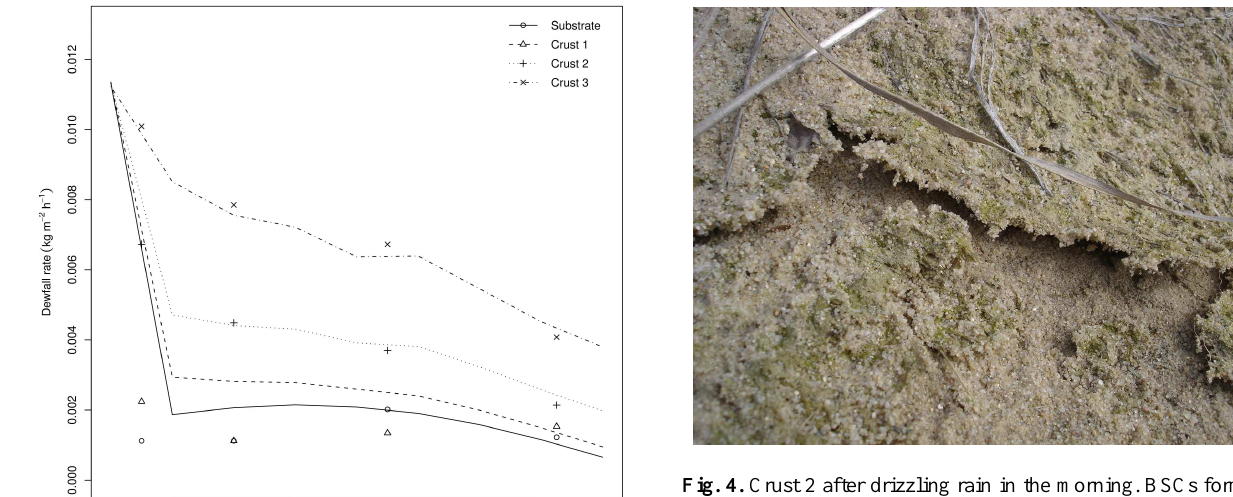
Fig. 4. Crust 2 after drizzling rain in the morning. BSCs formed a Figure 4 Crust 2 after drizzling rain in the morning. BSCs formed a moist layer over loose dry 462 moist layer over loose dry sand, so that no water flow into deeper sand, so that no water flow into deeper soil could be observed. Image: Maik Veste, May 21, 463 soil could be observed. Image: Maik Veste, 21 May 2008. 464